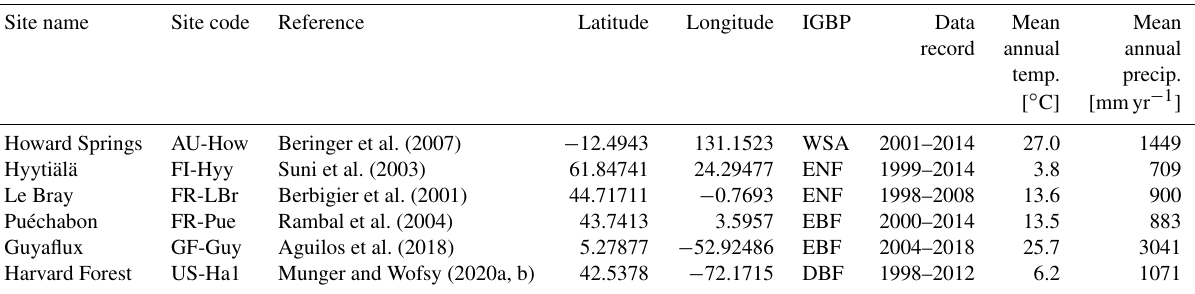
Table 2. Summary of sites, showing their location, FLUXNET code, observational time period, mean climate information, and ecosystem type. Latitude is given in − 90 / 90 and longitude is − 180 / 180. Ecosystem type is denoted using the International Geosphere-Biosphere Programme (IGBP) classification. DBF: deciduous broadleaf forest; EBF: evergreen broadleaf forest; ENF: evergreen needleleaf forest; WSA: woody savanna.